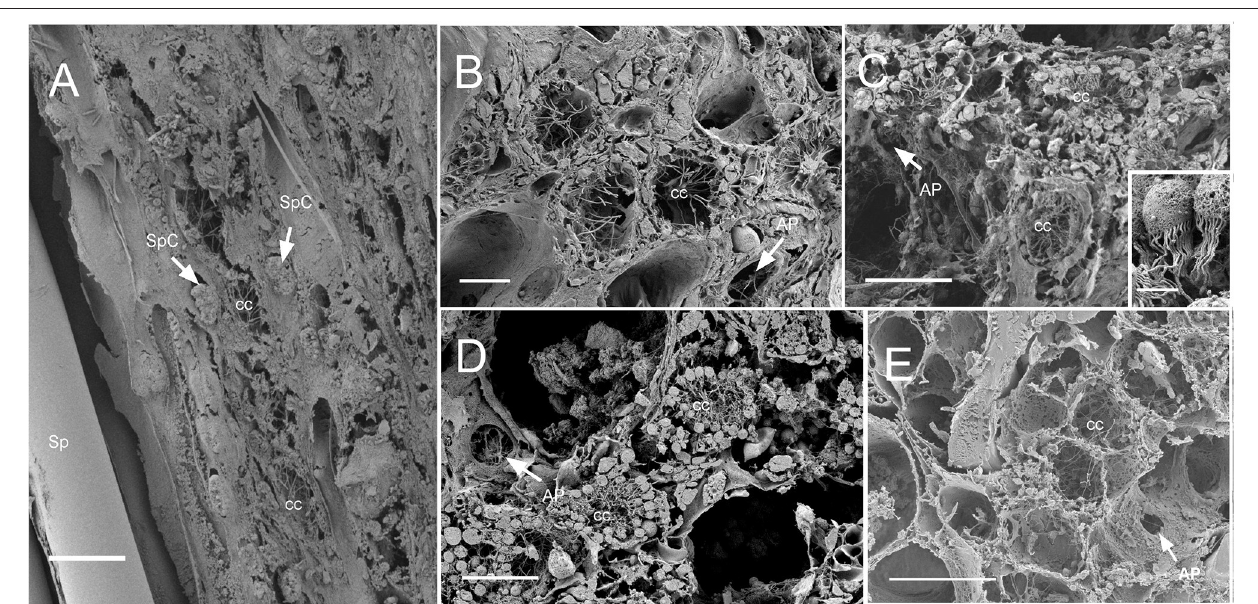
FIGURE 8 | SEM of chaonocyte chambers. (A) The choanocyte chambers (CC) and the spherulous cells (SpC) are present in the sponge Cinachyrella cf. cavernosa , spicules are indicated with sp. (B) The CC in Amorphinopsis foetida . The apopyle (AP) is indicated with a white arrow. (C) Calyspongia sp. with the choanocyte chamber (cc) and the apopyle (AP) indicated with a white arrow. The inset shows a closeup of the choanocytes with the flagella and microvillar collar, individual microvilli can be seen connected with glycocalyx mesh. (D) Haliclona sp. CC and the flagella of another choanocyte chamber seen through Apopyle (AP) indicated with white arrow. (E) Ircinia fusca CC and the apopyle (AP). Scale bar: (A) 20 µ m; (B) 10 µ m; (C) 20 µ m, inset 2 µ m; (D) 20 µ m; (E) 50 µ